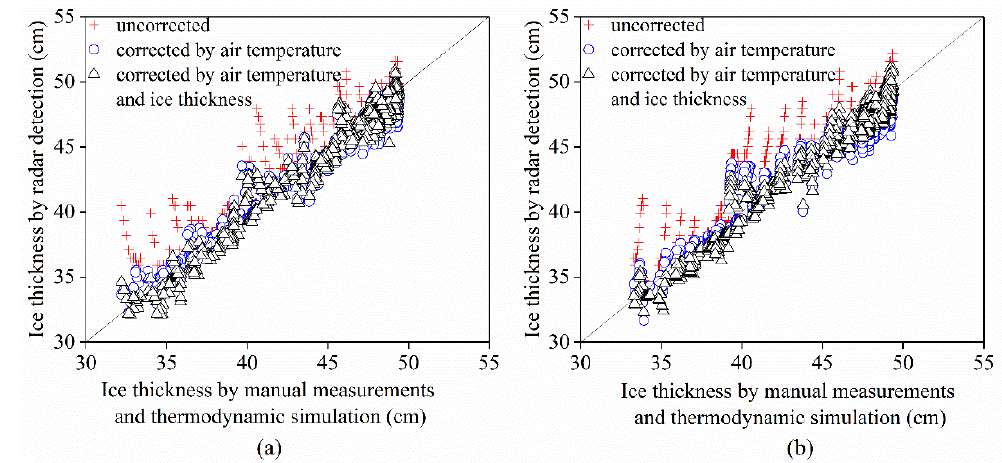
Table 3. Statistical coefficients and the correlation coefficient of different statistical methods.